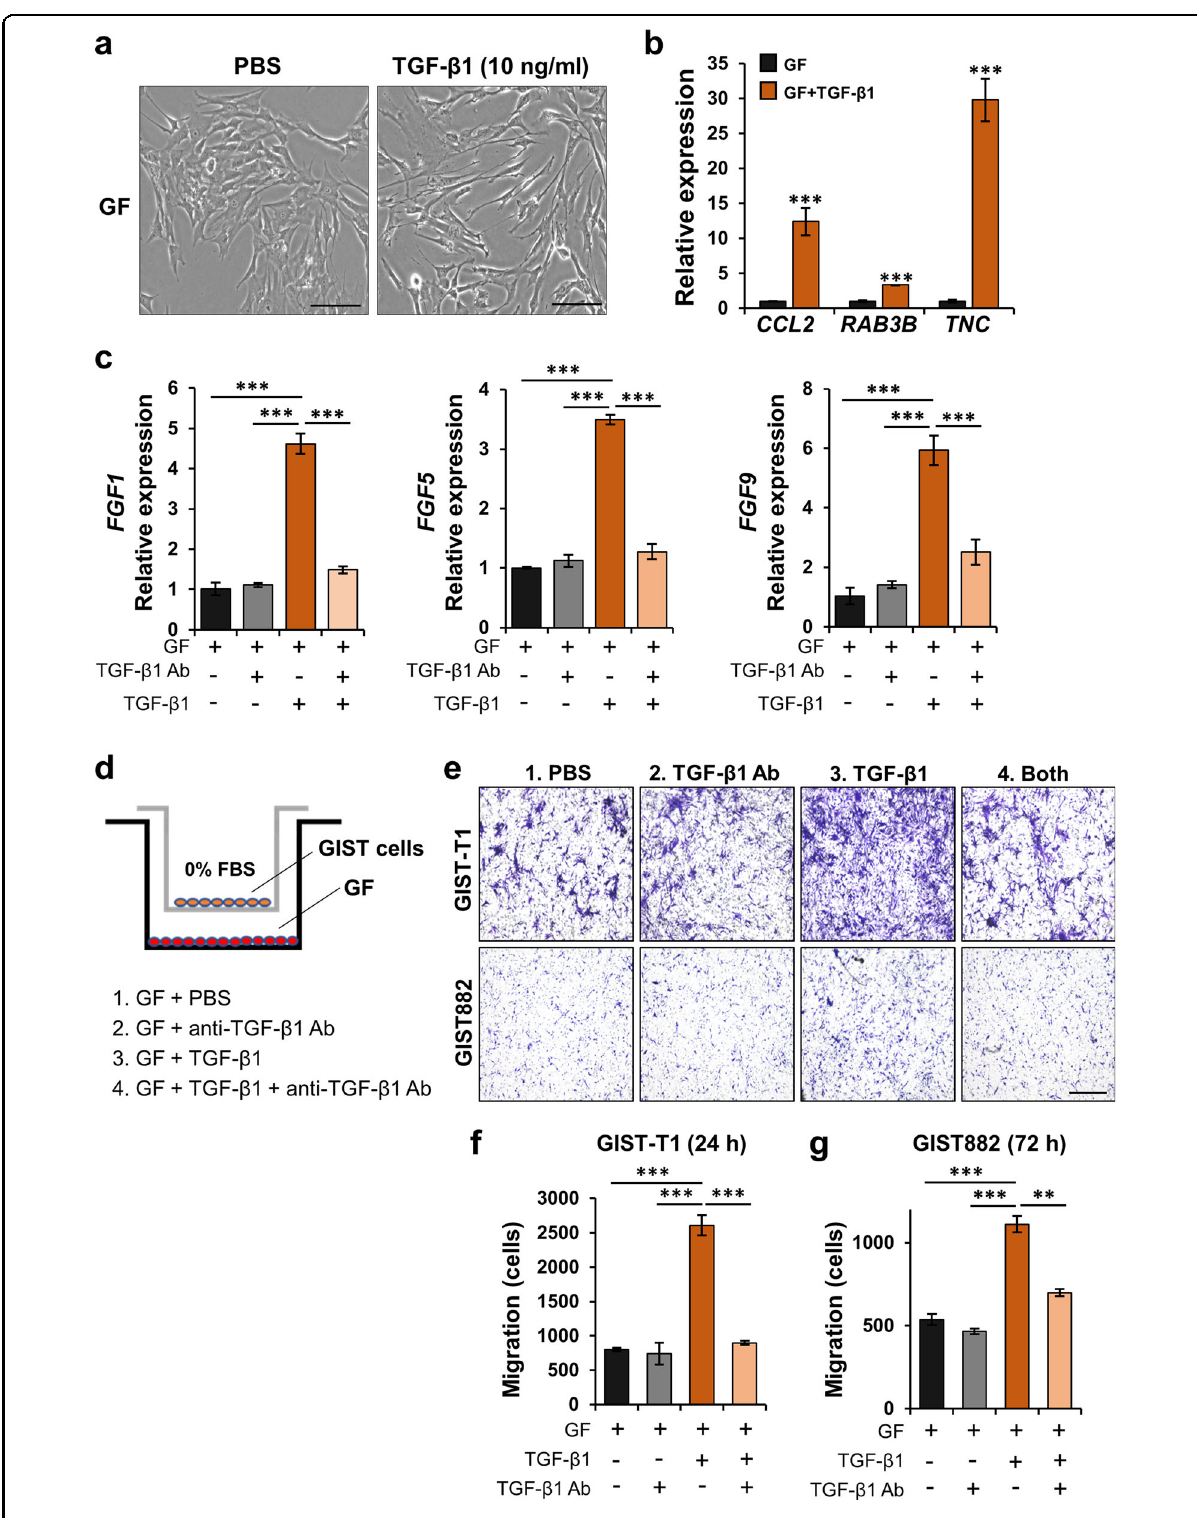
Fig. 4 (See legend on next